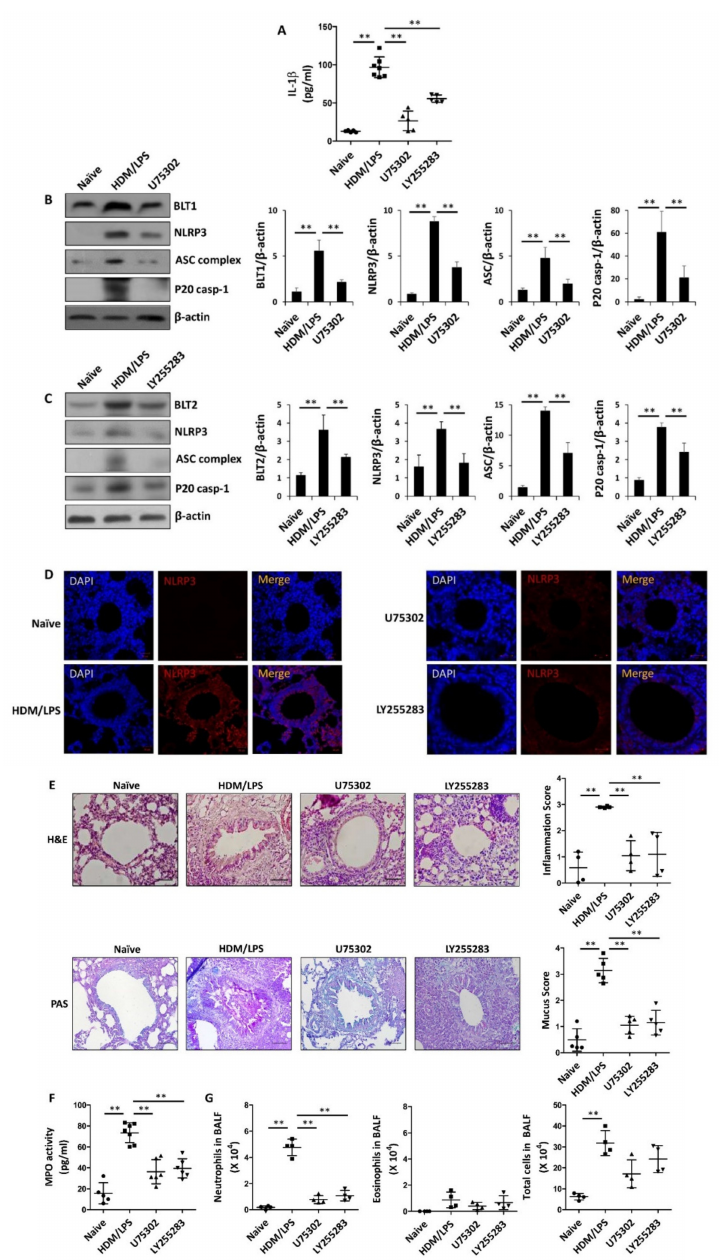
Figure 3. LTB 4 receptors are necessary for NLRP3 stimulation and IL-1 β production in HDM/LPS-induced neutrophilic airway inflammation. The control DMSO, U75302 (50 µ g/kg) or LY255283 (10 mg/kg) were administered via i.p. injection 1 h before every challenge. Naïve designates control without any additions. ( A ) Levels of IL-1 β in lung lysates were analyzed using ELISA. Data are shown as the mean ± SD ( n = 57 per group). ( B , C ) The mouse lungs were homogenized, protein was isolated, and the levels of BLT1/2, NLRP3, caspase-1, and ASC complex were assessed by Western blotting. Data are representative of three independent experiments with similar results. ( D ) Immunofluorescence staining for NLRP3 (red, CY TM 3) in lung tissues. Nuclei were stained with DAPI (blue) (400 × ). The images are representative of three independent experiments with similar results. ( E ) The lungs were excised, fixed and stained with H&E and PAS. Peribronchial and perivascular lung inflammation and goblet cells were measured and scored (400 × ). Data are shown as the mean ± SD ( n = 4–5 per group). ( F ) Levels of MPO in lung lysates were analyzed using ELISA. Data are shown as the mean ± SD ( n = 5–7 per group). ( G ) Neutrophils, eosinophils, and total immune cells in BALF were obtained using Cytospin and stained with Diff-Quik. Data are shown as the mean ± SD ( n = 4 per group). All experiments were performed in triplicate. ** p < 0.01 versus each control